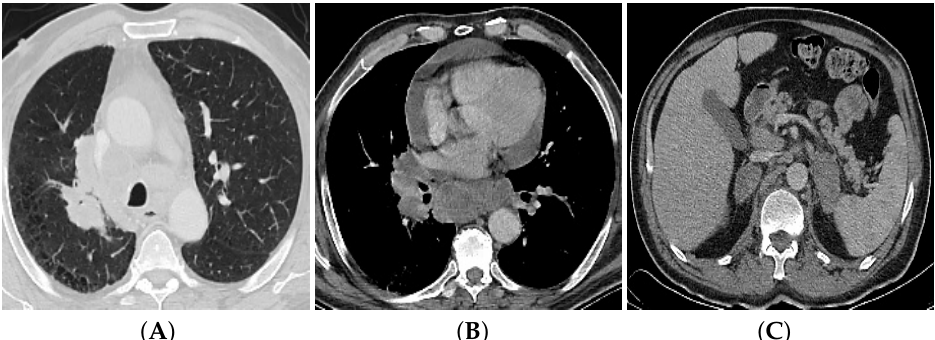
Figure 1. A 64-year-old male cigarette smoker with bronchogenic adenocarcinoma. Axial CT image ( A ) reveals spiculated right upper lung lobe mass (4.5 × 2.5 cm). Axial CT image at distal level ( B ) reveals ipsilateral hilar, mediastinal LN with central necrosis, and pericardial effusion. Axial CT image of upper abdomen ( C ) reveals bilateral metastatic suprarenal